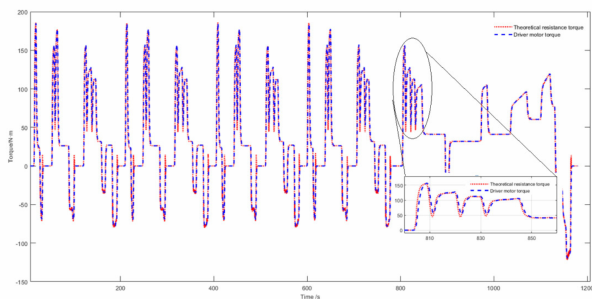
Figure 11. The theoretical resistance torque and drive motor torque.